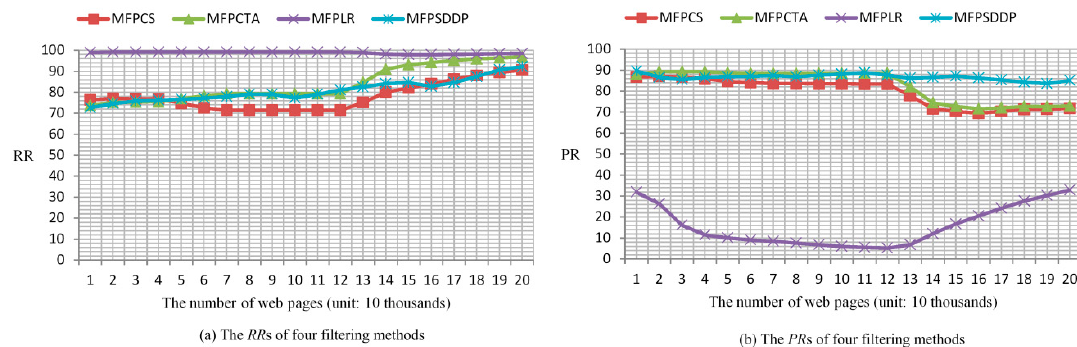
Figure 5. The experimental results of the accuracies of four filtering methods.